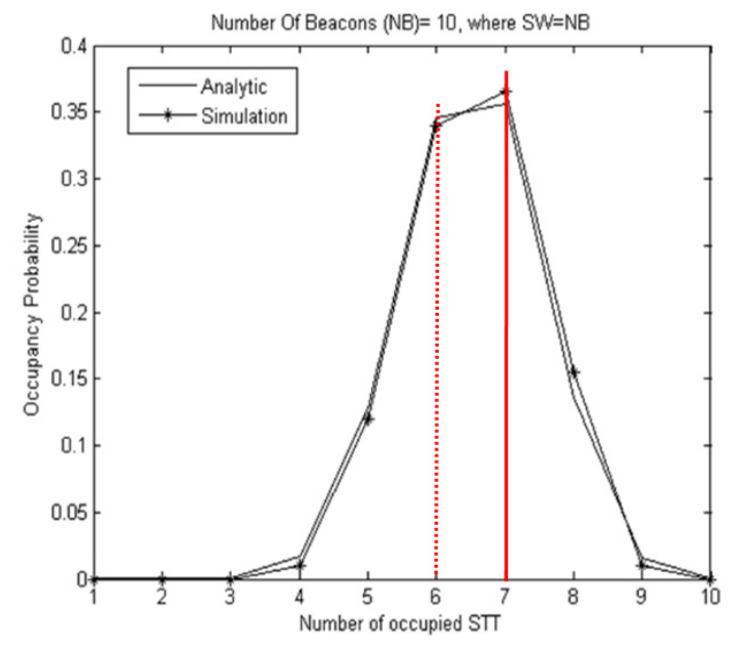
Figure 4. Comparison between the analytical and the simulation results of the occupancy probability for a number of beacons equal to 10, where SW=NB.